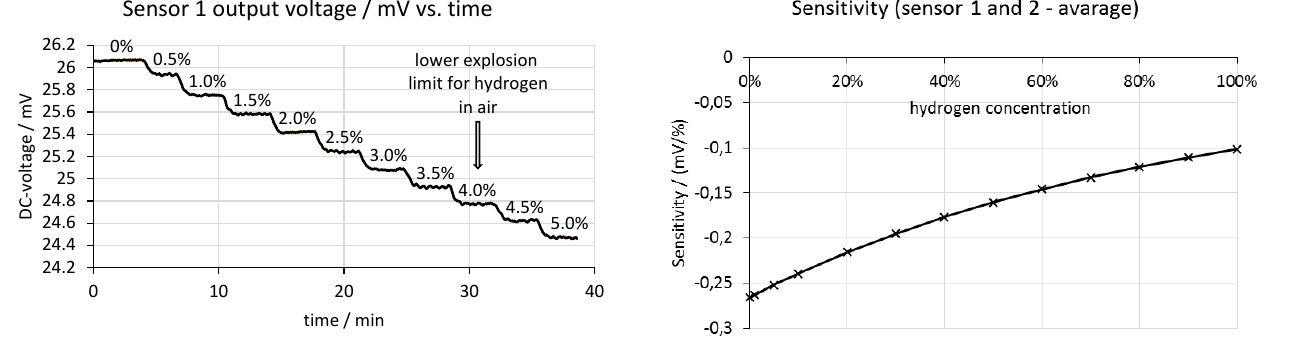
Figure 9. Sensitivity at different hydrogen concentrations.